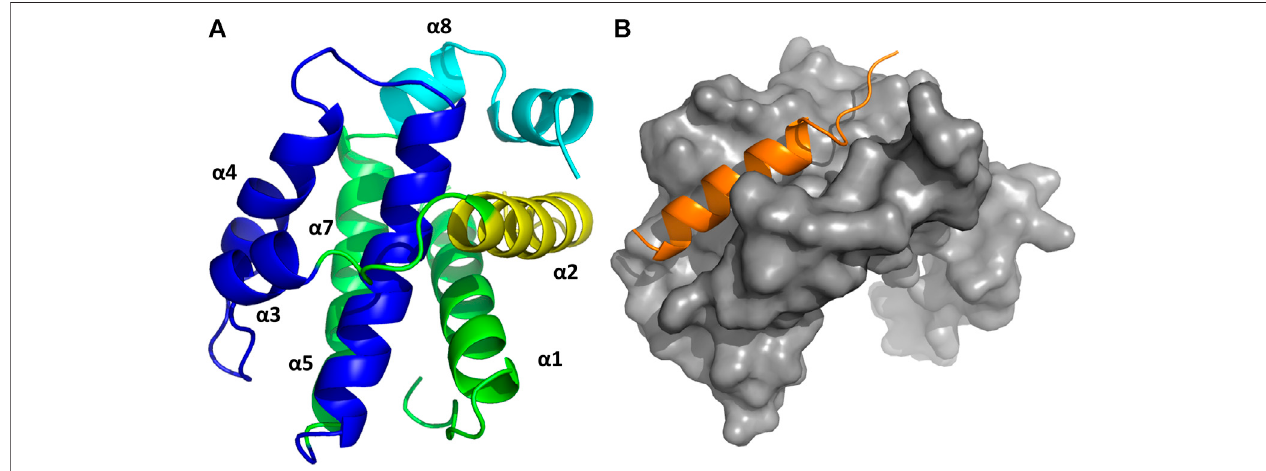
FIGURE5|(A) 3Dstructure ofBcl-xL (PDBID:1MAZ)withthediverseelementsofsecondary structure labeled.TheBHdomains arecolor-coded:BH1navyblue; BH2 cyan; BH3 yellow; BH4 dark green. (B) 3D structure of the complex Bcl-xL/BH3-Bak (in orange) (PDB